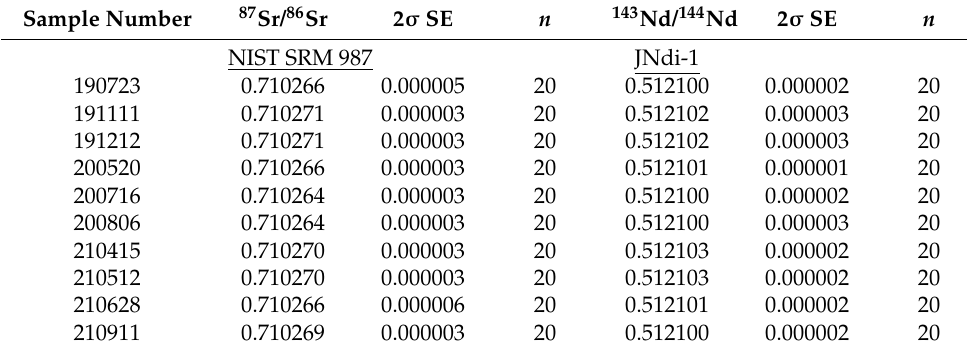
Table 3. TIMS results for NIST SRM 987 and